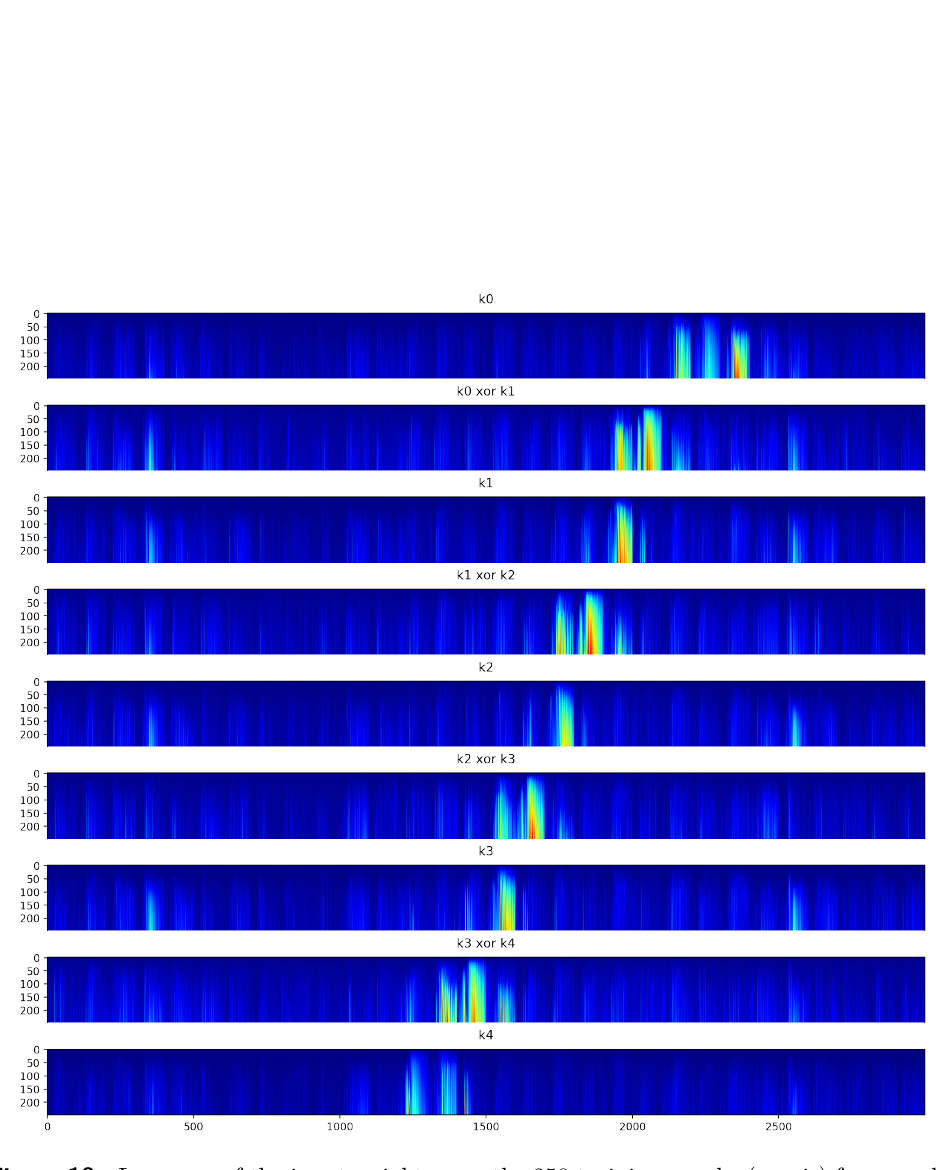
Figure 10: L ∞ norm of the input weights over the 250 training epochs (y-axis) for a model trained on five distinct